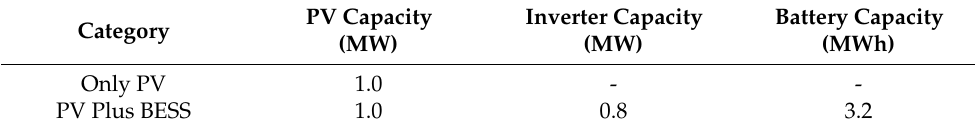
Table 2. Average Ratio of PV Plus BESS Size on Front-the-Meter Data.